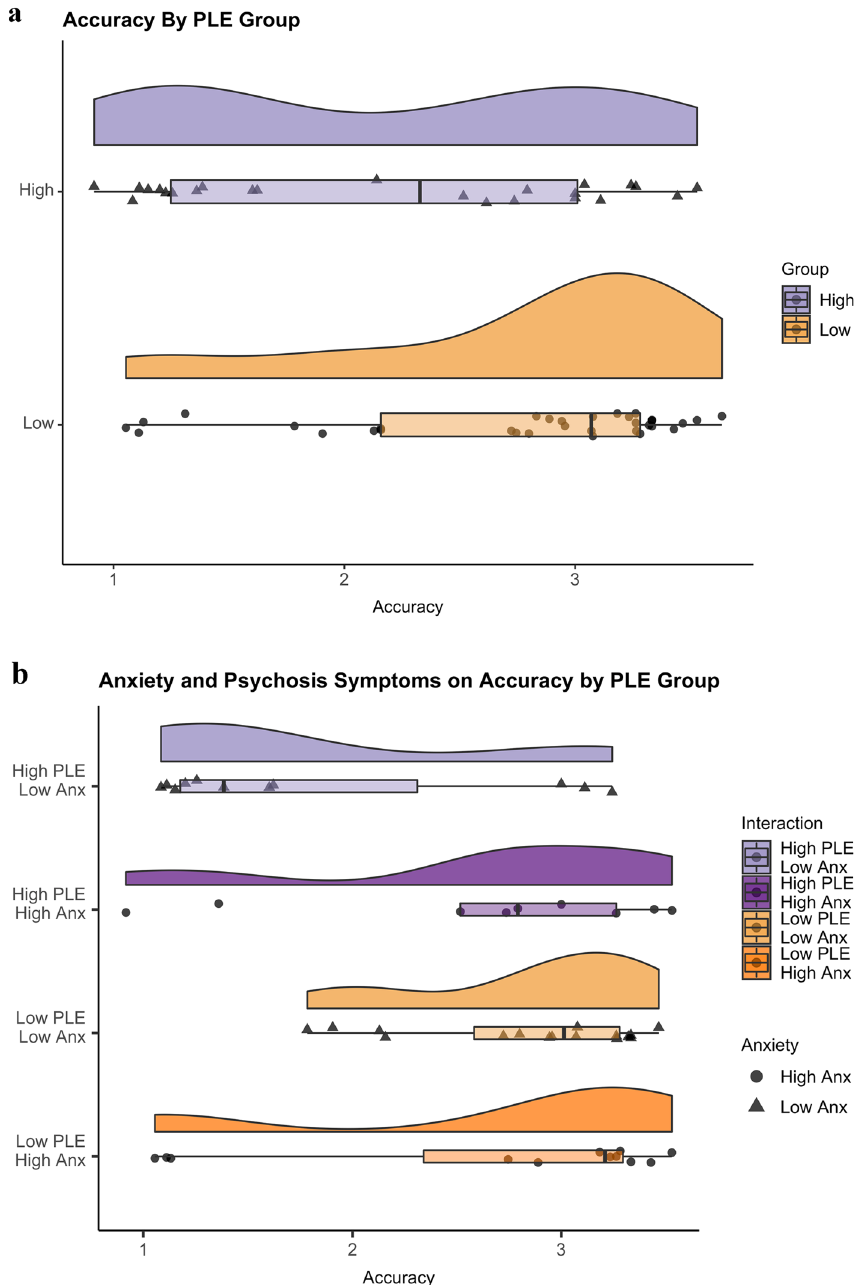
Figure 2. ( a ) Accuracy by PLE group . Each dot represents the value from each individual. The distribution of values is indicated by the density plot as well as the box plot. Overall, the high-PLE group made significantly less accurate responses compared to the low-PLE group. PLE Psychotic-Like Experiences. ( b ) Accuracy relates to anxiety symptoms in the high-PLE group. Individuals with greater levels of anxiety in the high-PLE group made accurate responses comparable to those with low-PLE. Note that the PLE groups were divided into different high/low anxiety groups for illustrative purposes only and all analyses treated anxiety symptoms continuously. Anx anxiety symptoms, PLE psychotic-like